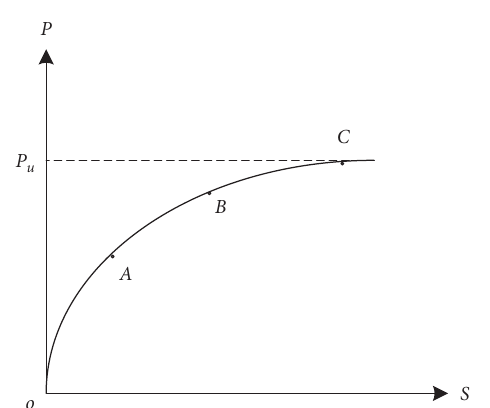
Figure 2: Schematic diagram of the load-displacement response of a